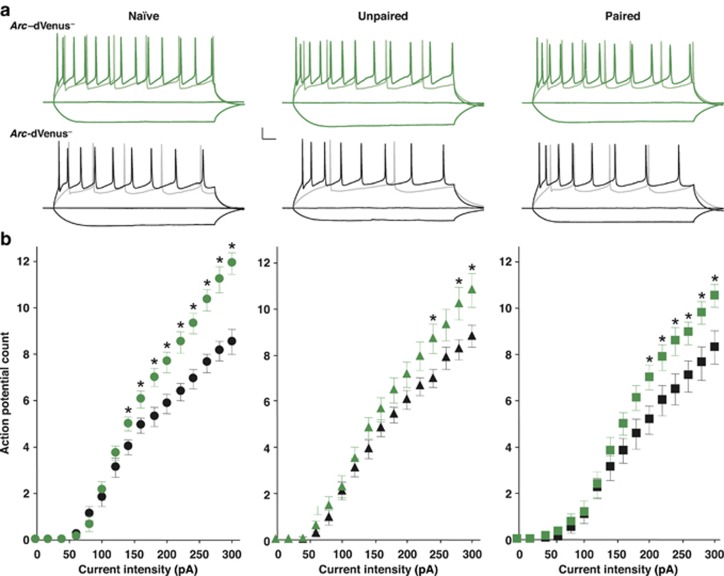
Arc-dVenus+ neurons exhibit increased excitability. (a) Superimposed current-clamp recordings with −100, 0, +140, +300 pA sustained current injection at a holding membrane potential of −75 mV. Arc-dVenus+ neurons (top) fire more APs than non-activated neighbors (bottom) in naïve, unpaired and paired conditions. Scale bars: 20 mV, 50 ms. (b) Plot of the mean AP count versus current injection intensity for naïve (left), unpaired (center) and paired (right) conditions. Arc-dVenus+ neurons (naïve: n=15, unpaired: n=17, paired: n=16; green) show higher excitability compared with neighboring Arc-dVenus− neurons (naïve: n=16, unpaired: n=17, paired: n=18; black). Naïve: n=12 mice, Unpaired: n=6 mice, Paired: n=8 mice. Repeated measures analysis of variance, Arc-dVenus × current intensity interaction: naïve, F=14.06, P<0.001; unpaired, F=3.75, P<0.05; paired, F=3.55, P<0.05. *P<0.05.